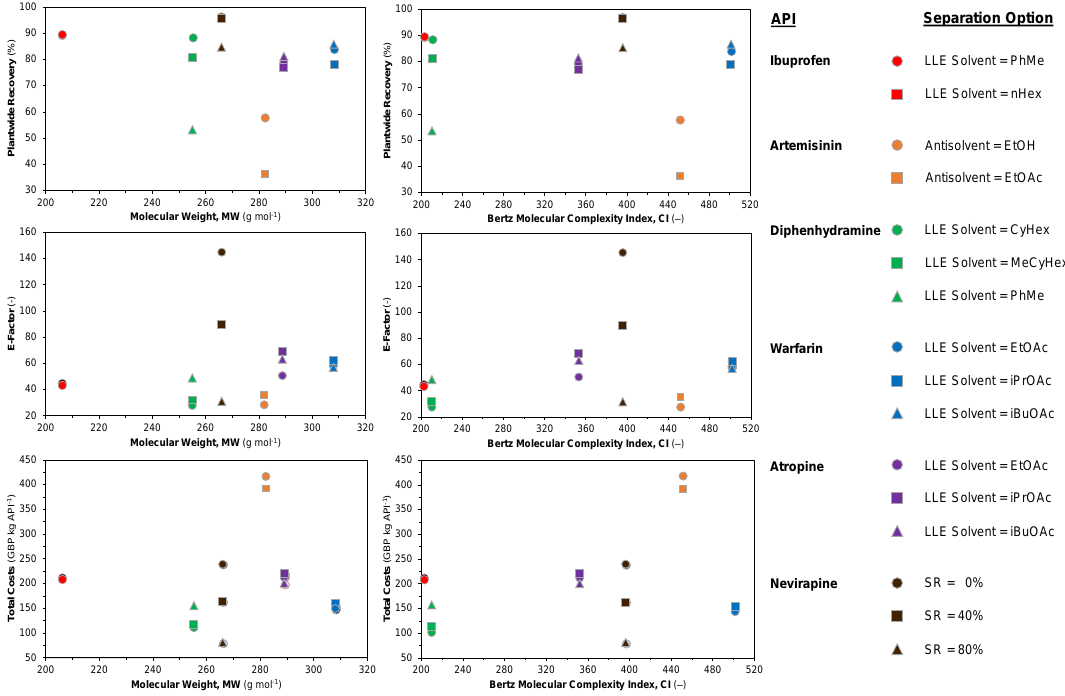
Figure 18. Performance metrics of various CPM processes for different APIs vs. Molecular Weight (MW) and Bertz Complexity Index (CI).